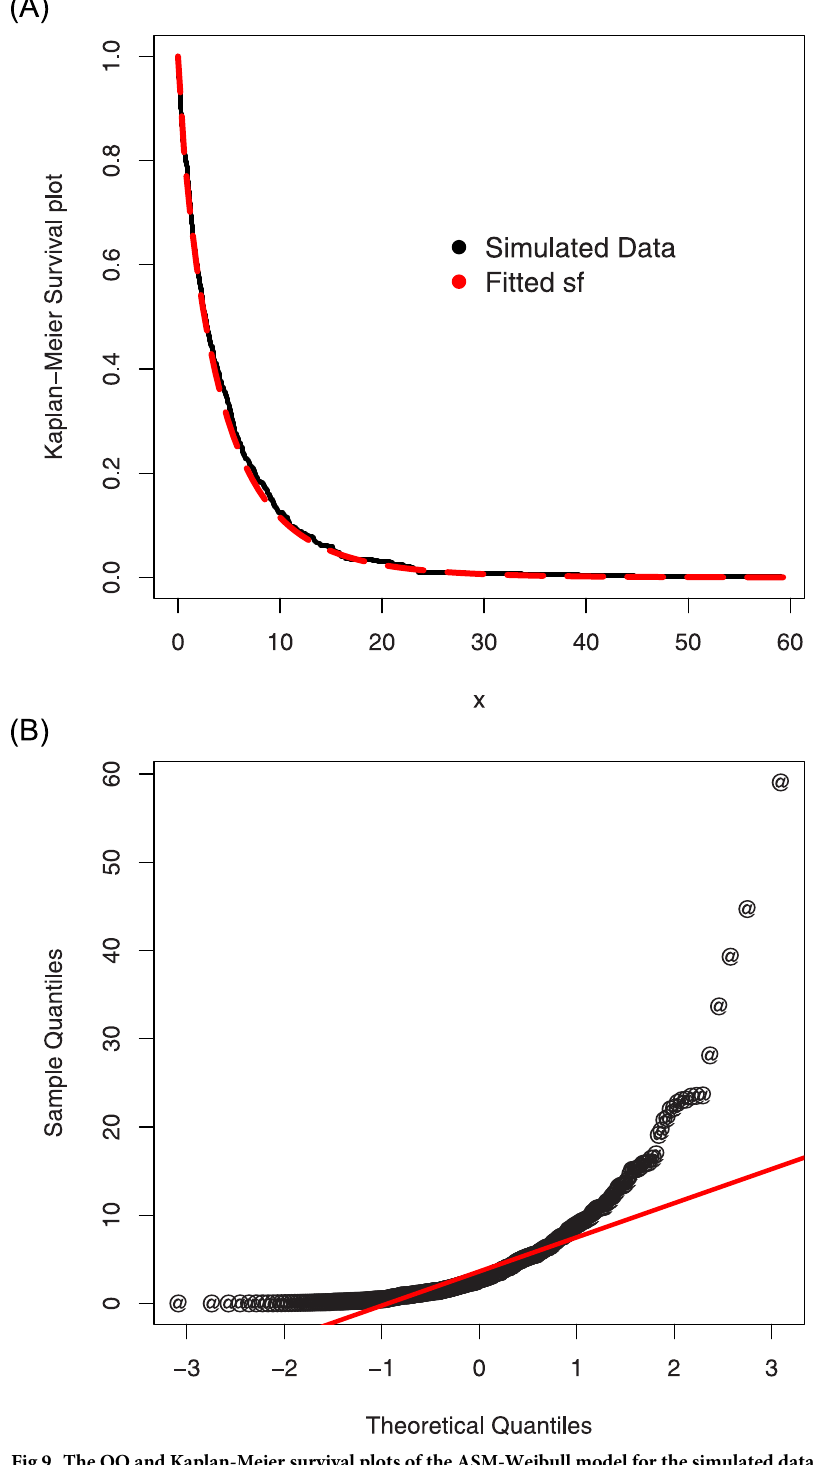
PLOS ONE | https://doi.org/10.1371/journal.pone.0254999 July 26,